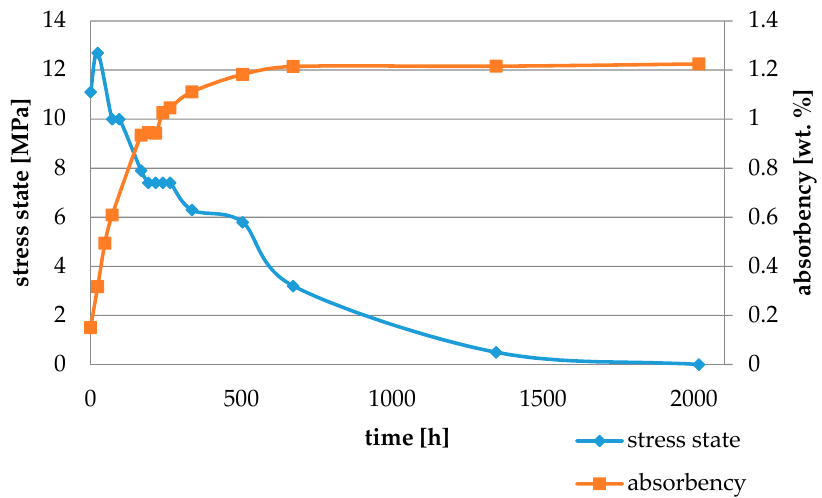
Figure 8. The influence of water sorption (2016 h water ageing) on the absorbency and contraction stress generated during the photopolymerization of Breeze.